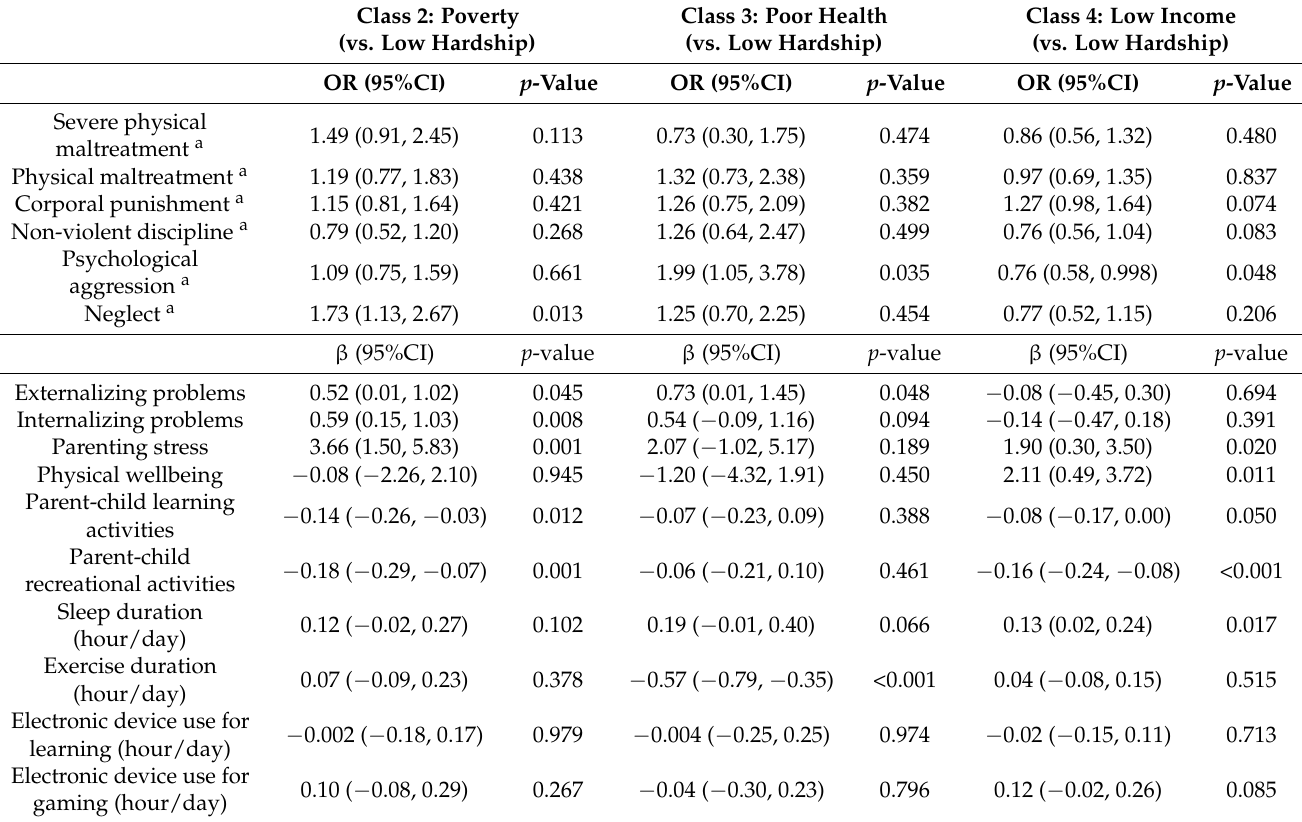
Table 4. Regression analyses indicating the relationship between family hardship classes and parent- ing and lifestyle practices and wellbeing under the COVID-19 pandemic. Class 2: